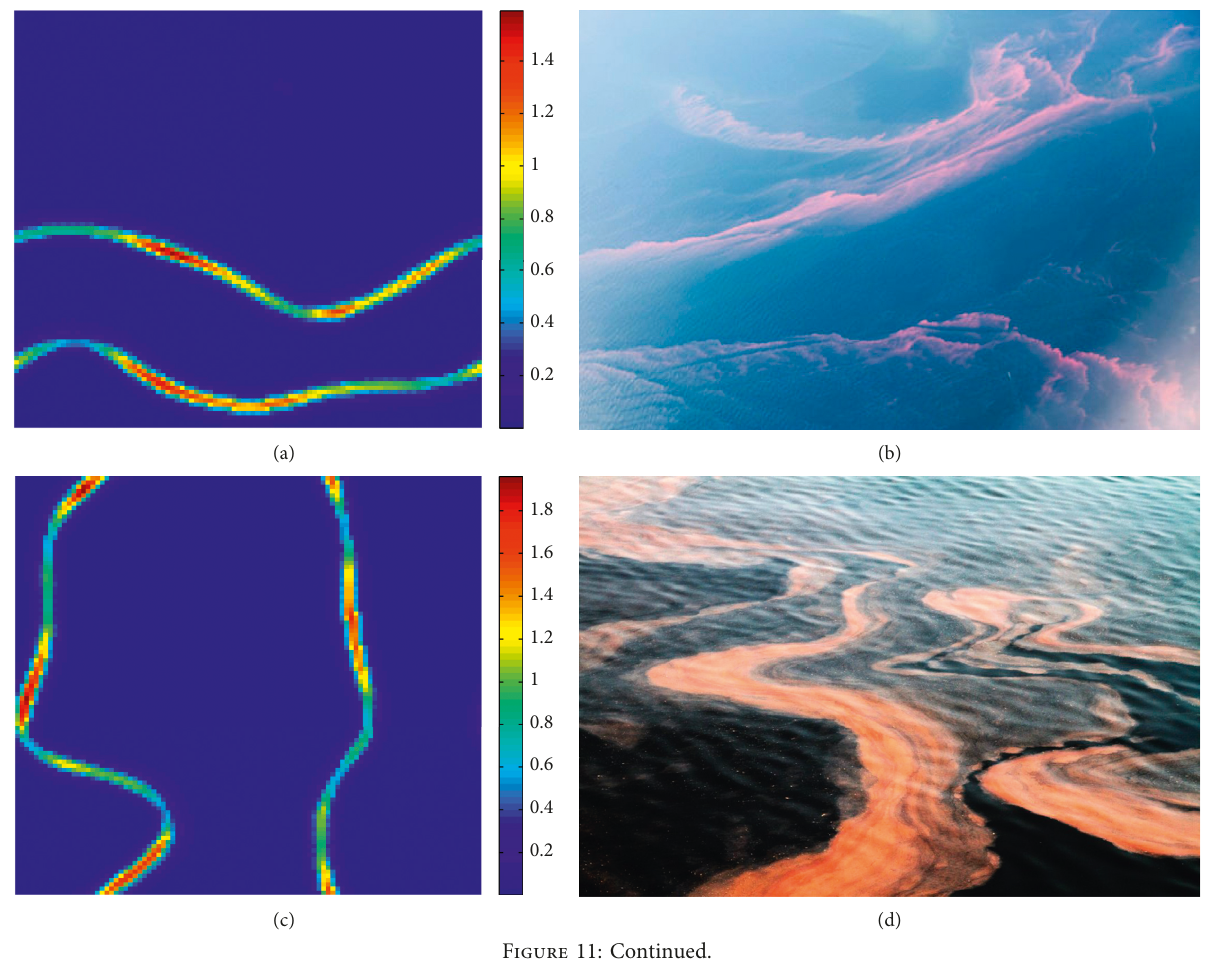
Figure 10: Cloud-like patterns. Parameter values: (a) I � 1 . 6, a � 0 . 5, b � 0 . 8, α � 0 . 7, m � 0 . 45, d ε � 0 . 001, t � 20000, n � 100, e � 0 . 2, and h � 1. (b) On June 24, 2010, in the North Atlantic, phytoplankton was photographed on a medium resolution imaging spectrometer on NASA’s “Aqua” satellite.